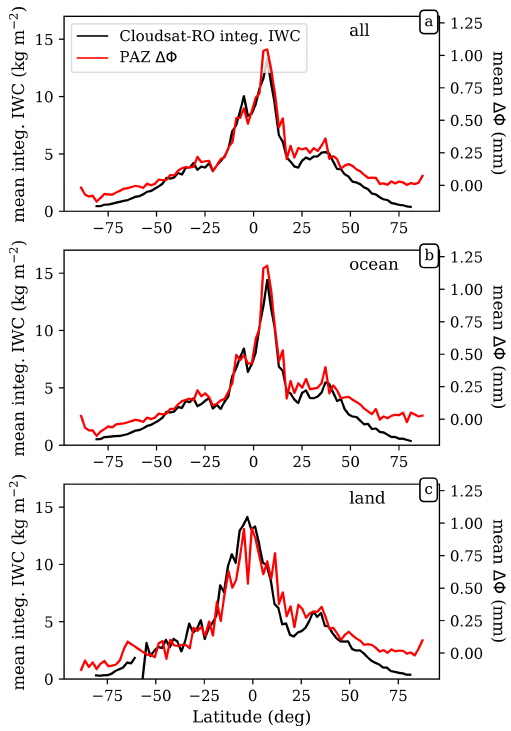
Figure 3. Mean values of integrated IWC (left axes) from the CloudSat-RO dataset and mean values of observed (cid:49)(cid:56) from PAZ (right axes), as a function of latitude, for all data (a) , over the ocean (b) , and on land (c) . Data correspond to tangent heights of 7km. The mean values are computed for every 2 ◦ latitude